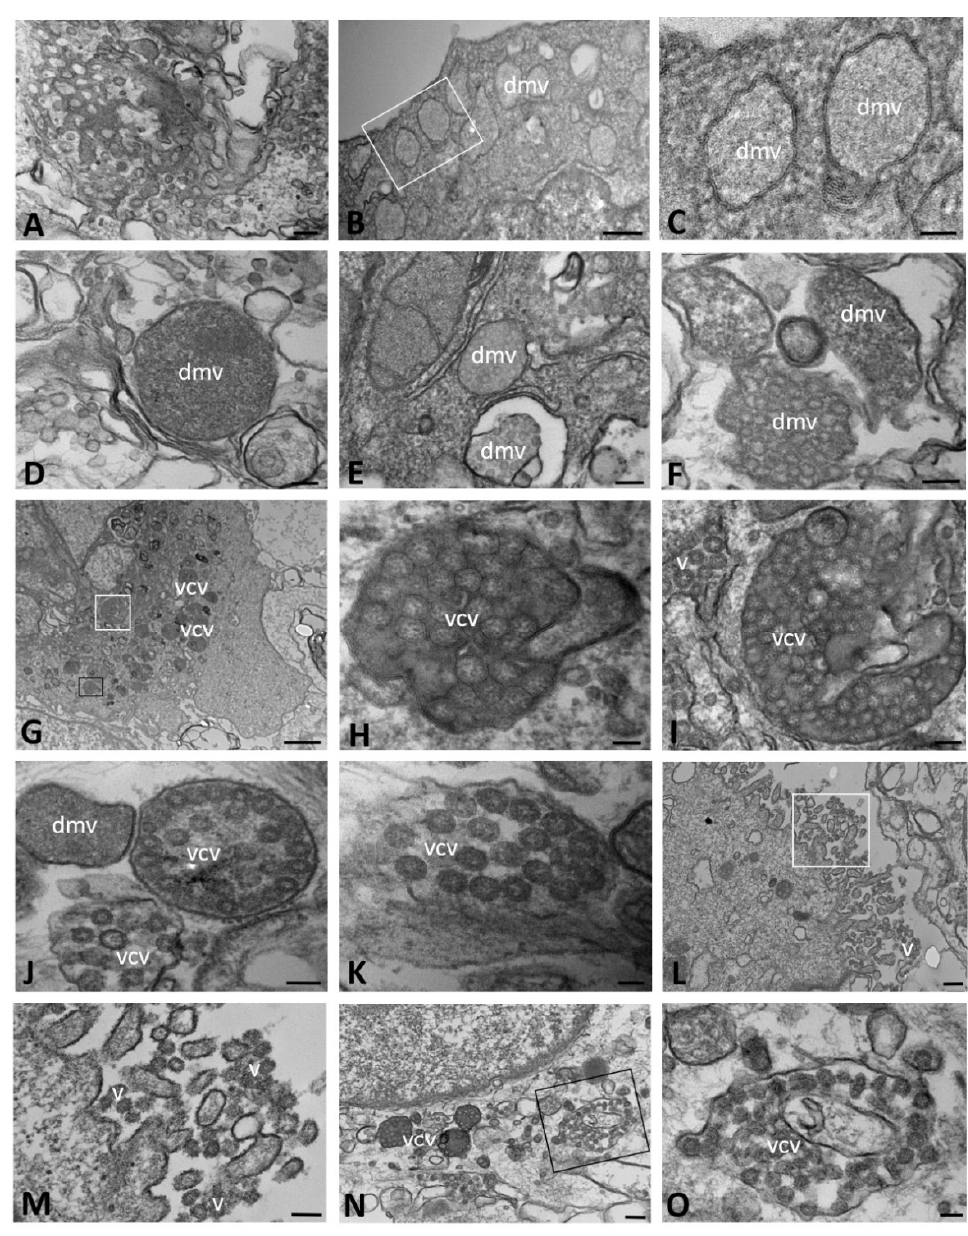
Figure 2. Transmission electron microscopy showing the viral replicative structures in SARS-CoV-2-infected CFBE41o- WT cells at late time points of infection (from 24 to 72 h post infection). Double- membrane vesicles with granular ( B , C , E , F ) and vesicular ( D , F ) content are visible. Virions are detected in single-membrane-bound vesicles ( J – K , N , O ) or on the cell surface ( L , M ). In ( B – D ), the sample was treated with tannic acid. The boxed area in ( B , L , N ) is enlarged in ( C , M , O ), respectively. The black boxed area in ( G ) is enlarged in ( H ) and the white boxed area is enlarged in ( I ). (dmv): double-membrane vesicle; (v): virions; (vcv): virion-containing vesicle. Bars: ( A , D – F , I , J , M , O ) 100 nm; ( B , L , N ) 200 nm; ( C , H , K ) 50 nm; ( G ) 1 µm.